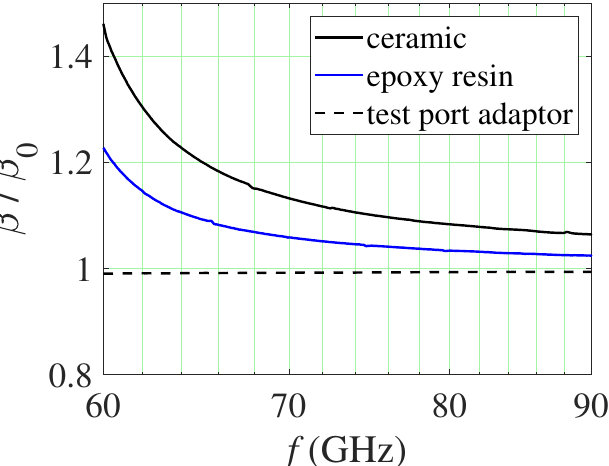
Figure 11. Measured normalized propagation constant of the fabricated WR12 waveguides compared to a test port